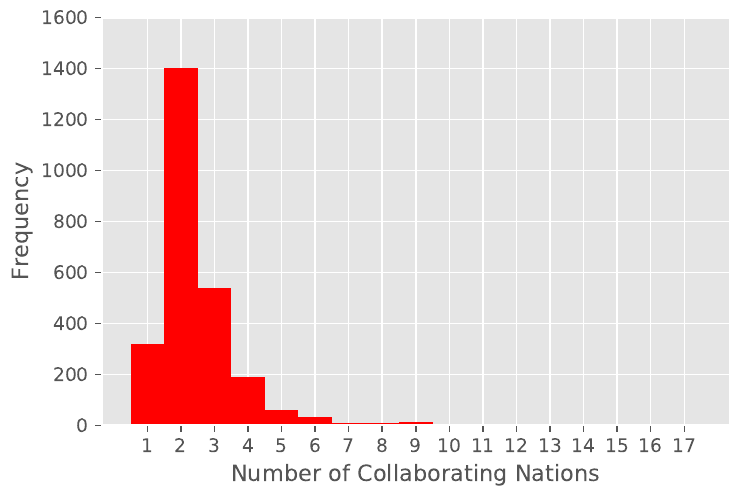
Figure 7. A histogram of the number of different nations represented on papers published in MDPI journals between 1996 and 2018 which include at least one author from a nation in the low-income